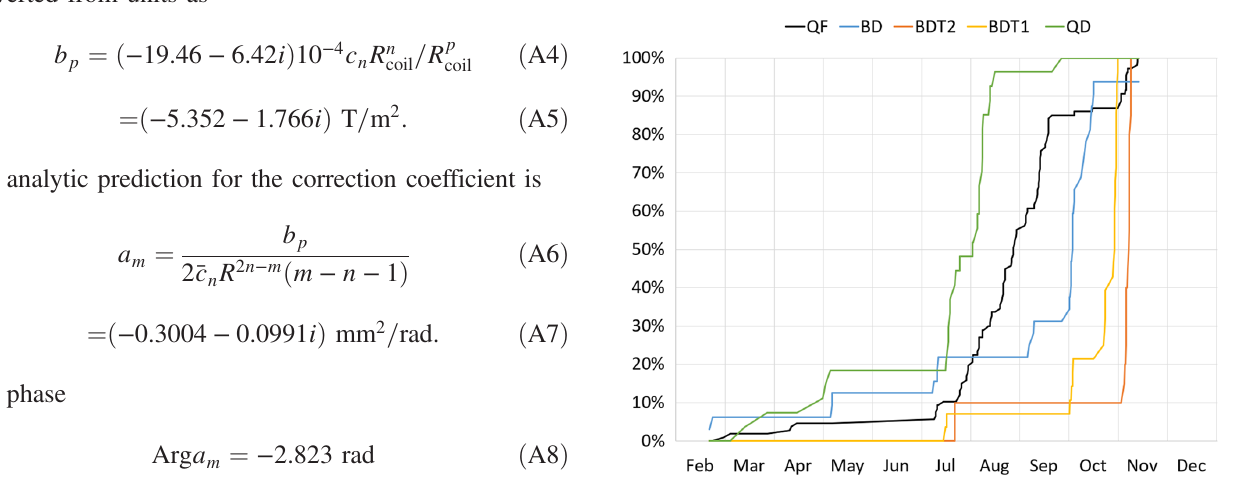
FIG. 15. Fraction of magnets completed over time.